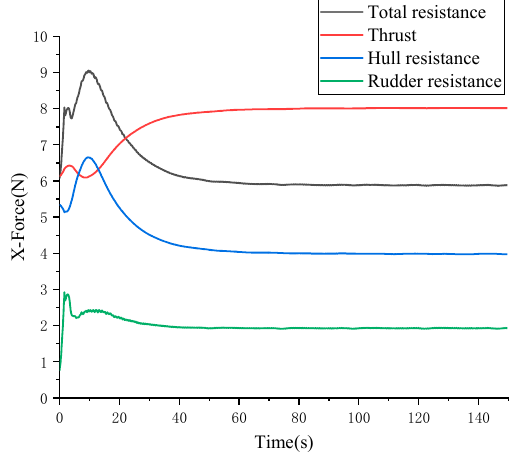
Figure 13. Force in − 35° X direction.